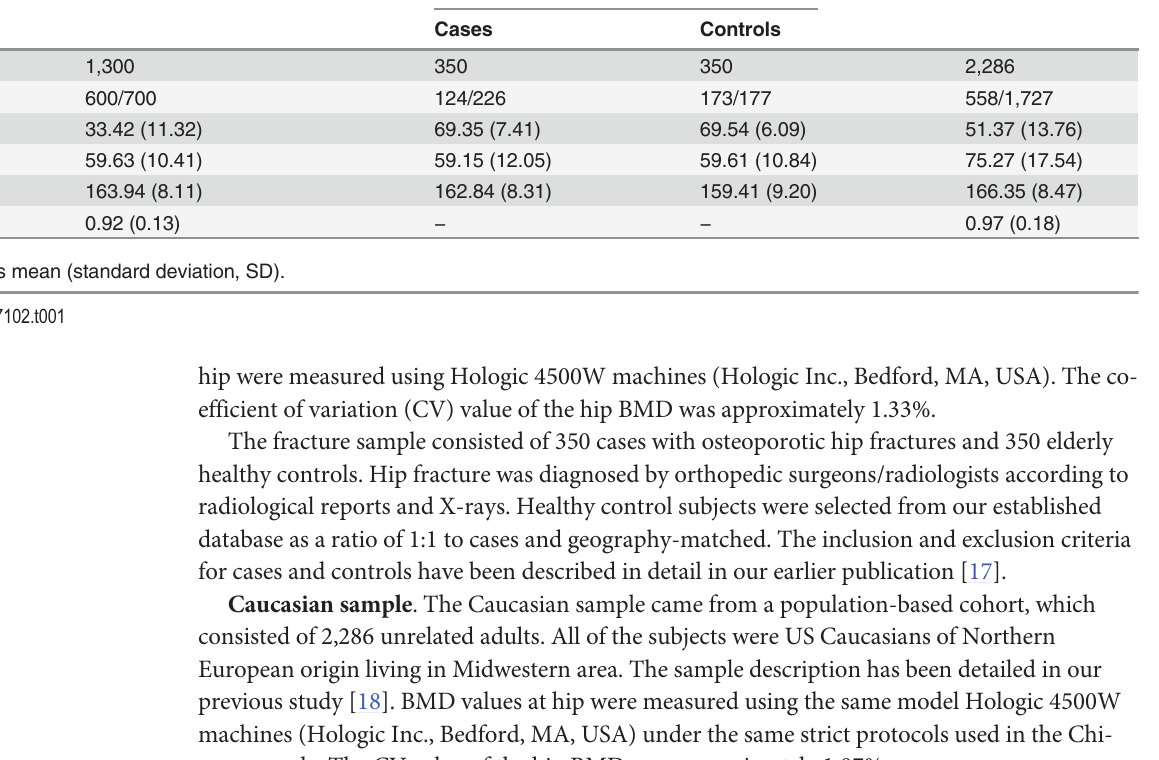
Table 1. Basic characteristics of the study subjects.